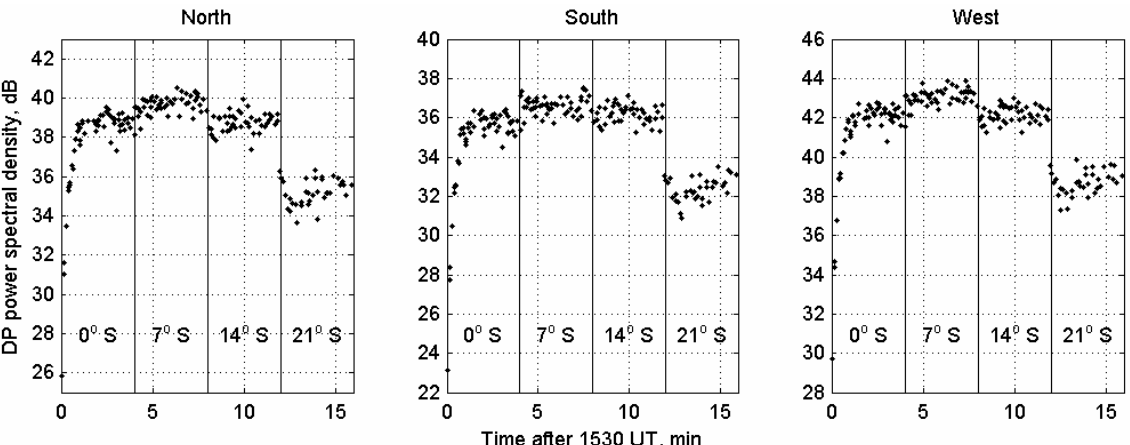
Fig. 6. Time variations of the power spectral density (PSD) of the SEE DP component for the three antennas, with zero dB corresponding to the noise level. Vertical lines show the times of the HF beam position changes while the text indicates the angle of the HF beam position. The time scale is in minutes from the initiation of pump modulation 1536-ms-on every 4s at 15:30 UT.